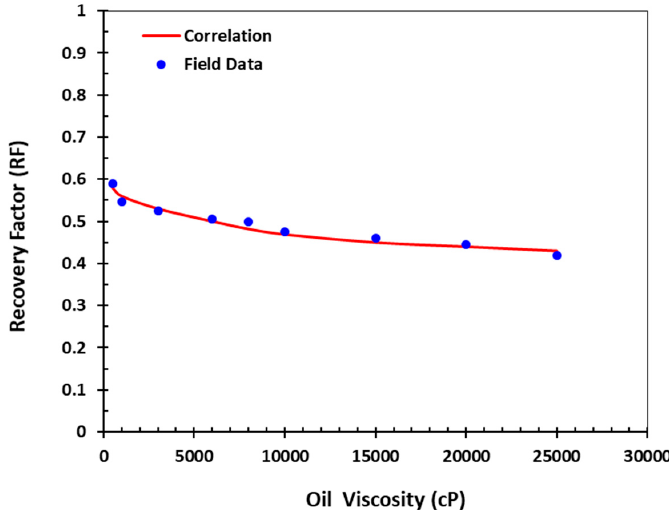
Figure 12. RF vs. oil viscosity for the database analyzed.